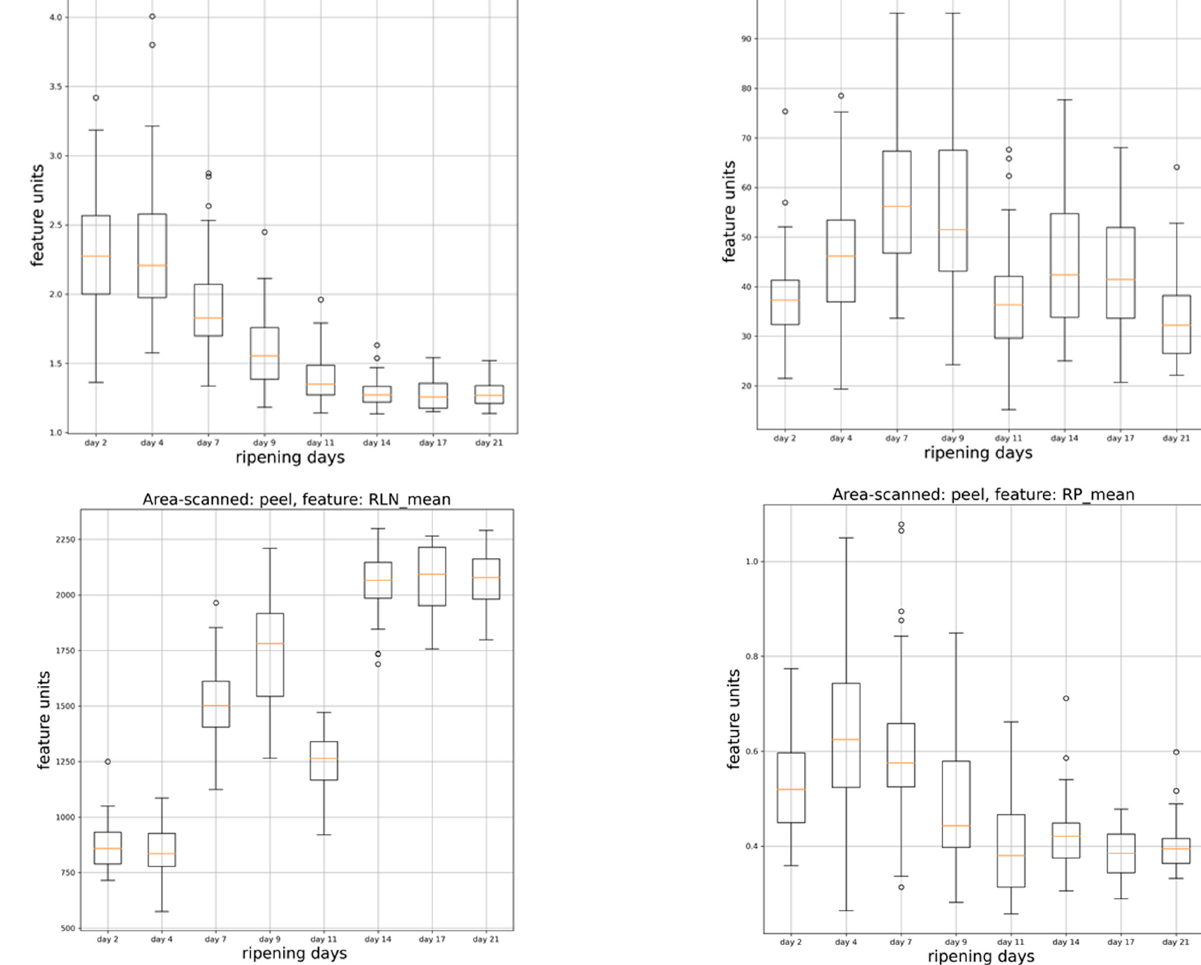
Figure 2. Variations of image analysis computed features (lightness L*, a* parameter, b* parameter, mean, standard deviation, skewness, kurtosis, contrast, dissimilarity, energy, homogeneity, correlation, angular second moment (ASM), short-run emphasis (SRE), long-run emphasis (LRE), gray-level non-uniformity (GLN), run-length non-uniformity (RLN) and run percentage (RP)) of the banana peel samples, according to storage intervals of 2, 4, 7, 9, 11, 14, 17, 21 days.